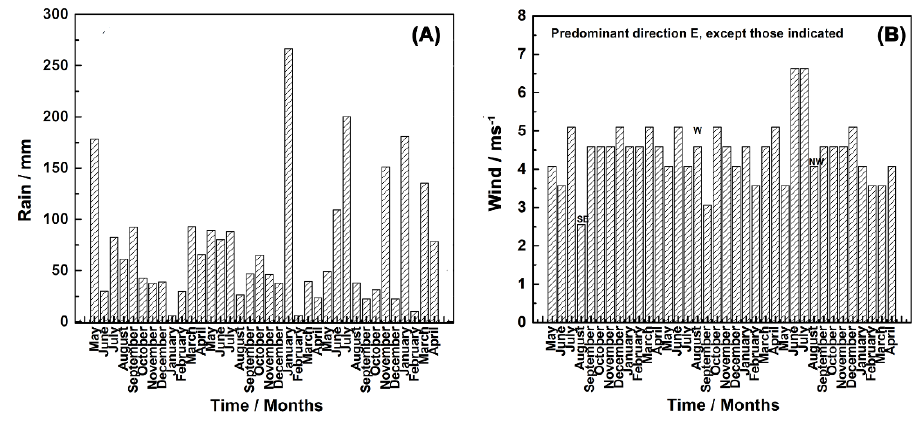
Figure 5. (A) Rainfall and ( B ) wind speed during the study period.